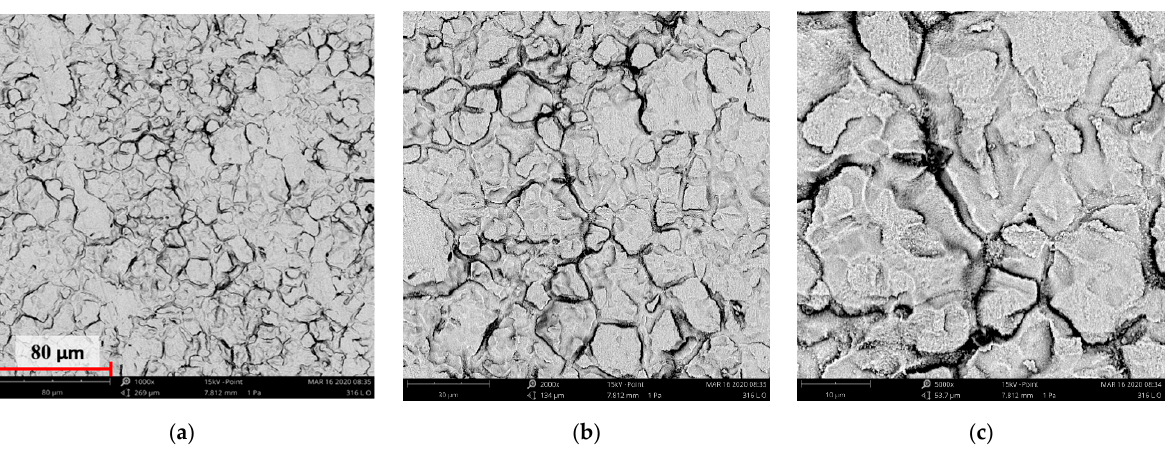
Figure 6. SEM image of the sample implanted with oxygen ions: ( a ) ×1000, ( b ) ×3000, ( c ) ×5000. The observations of the microstructures shown in Figures 4–6 reveal the granular characteristics of all samples. Granularity was more pronounced in the reference sample than in those implanted with nitrogen and oxygen ions. In addition, a higher etched area void fraction was observed on the surface implanted with nitrogen ions. As a result, the surface became more homogeneous, as confirmed by the geometric structure